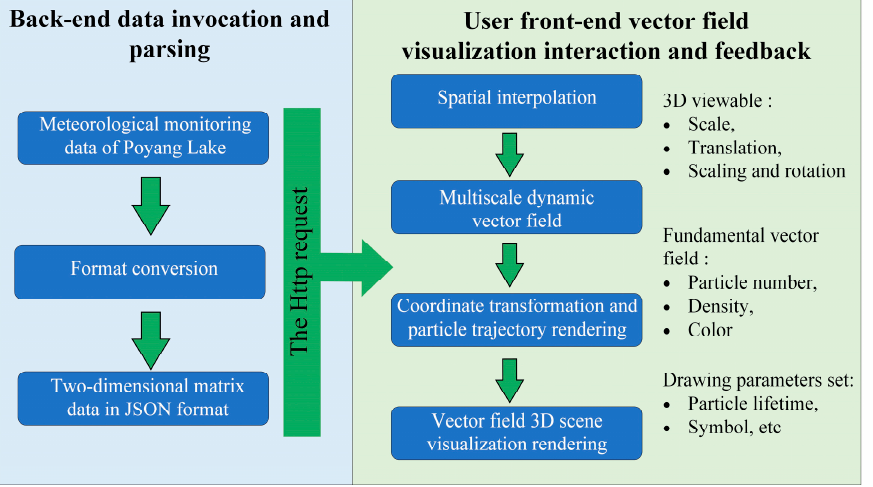
Figure 2. Monitoring data vector field visualization algorithm flow.